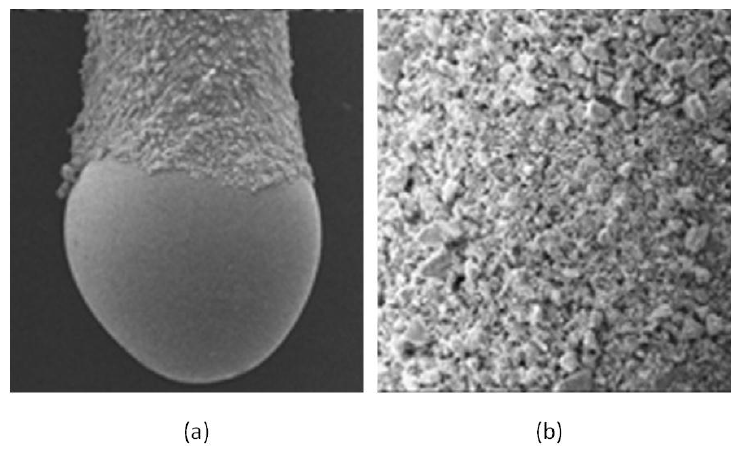
Figure 1. Scanning electron microscopy (SEM) picture of the ( a ) dumbbell-shaped stir bar (magnification 40×) and ( b ) the surface of the coating (magnification 150×). Reproduced with permission from [19], copyright Elsevier, 2012.